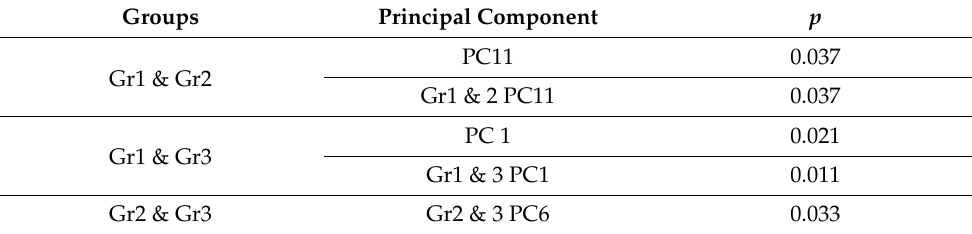
Table A3. Principal components that were significantly different between groups (ANOVA).